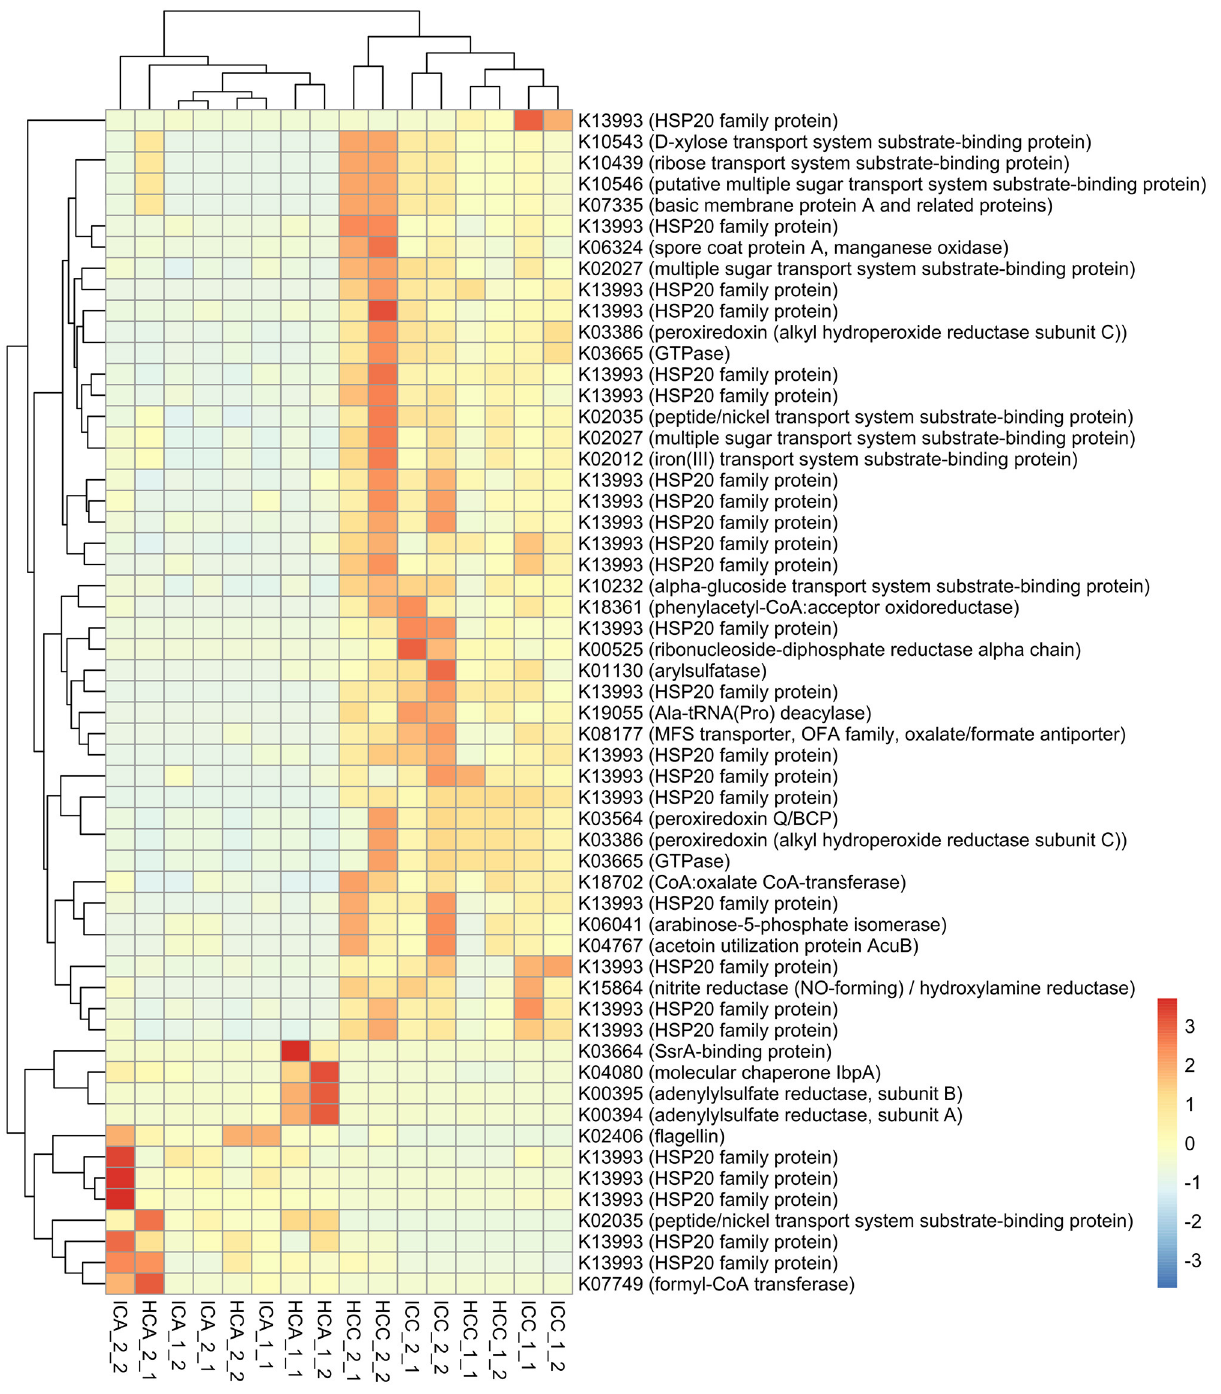
FIGURE 8 | Heatmap showing transcripts which were differentially expressed between 0 and 1,000m samples of embayments. IC, Iron Cove; HC, Hen and Chicken Bay; A, 0m; C, 1,000m; 1_1, February Replicate 1; 1_2, February Replicate 2; 2_1, March Replicate 1; 2_2, March Replicate 2. The colour scale refers to log2 fold change normalised to the mean in each